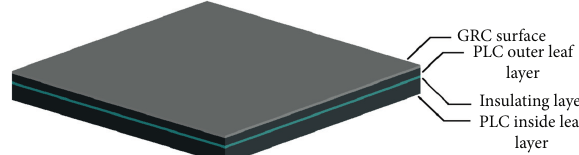
Figure 1: Three-dimensional model of a GRC-PLC-integrated